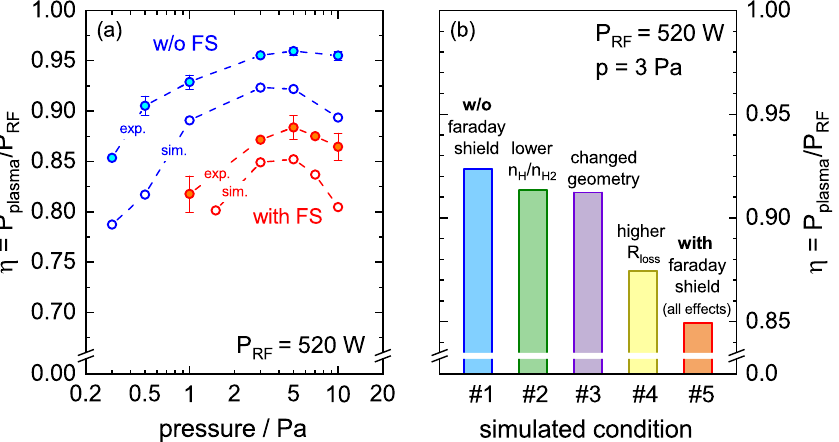
Figure 5. ( a ) Comparison of the experimentally measured RF power transfer efficiency with and without Faraday shield at varying pressure with the associated results obtained by the self consistent fluid simulation. ( b ) Contribution of different effects caused by the Faraday shield to the total reduction of the RF power transfer efficiency, as obtained from the simulation at a pressure of 3